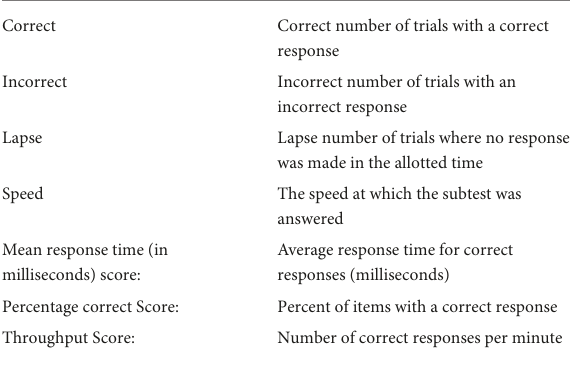
TABLE 2 Descriptions of variables automatically generated by Ped-ANAM battery*.